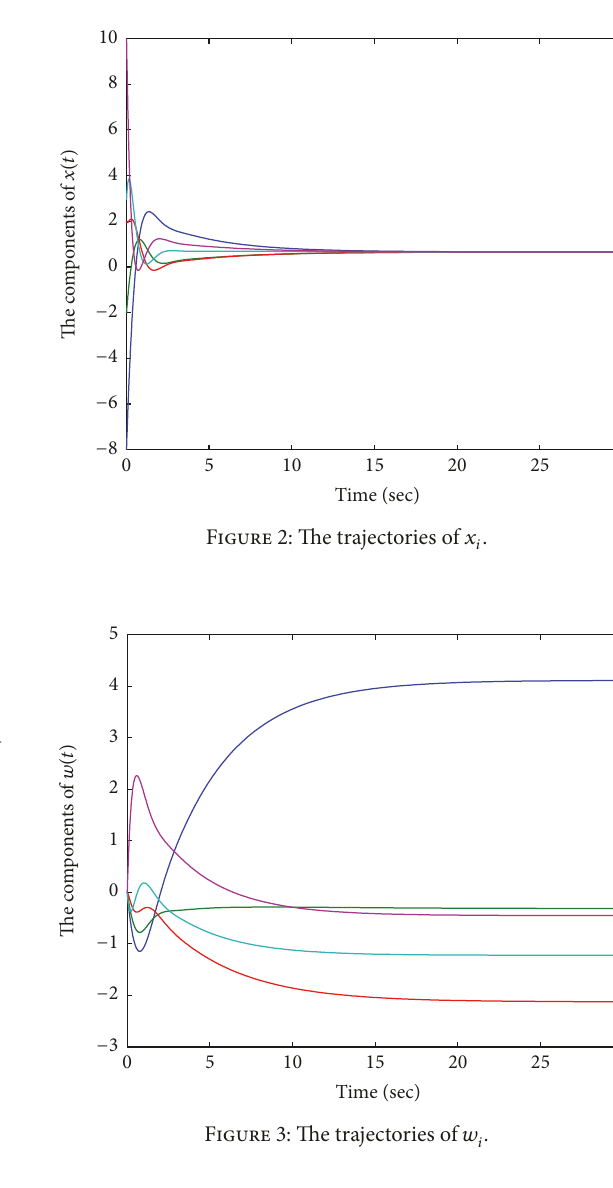
Figure 3: The trajectories of 𝑤 𝑖